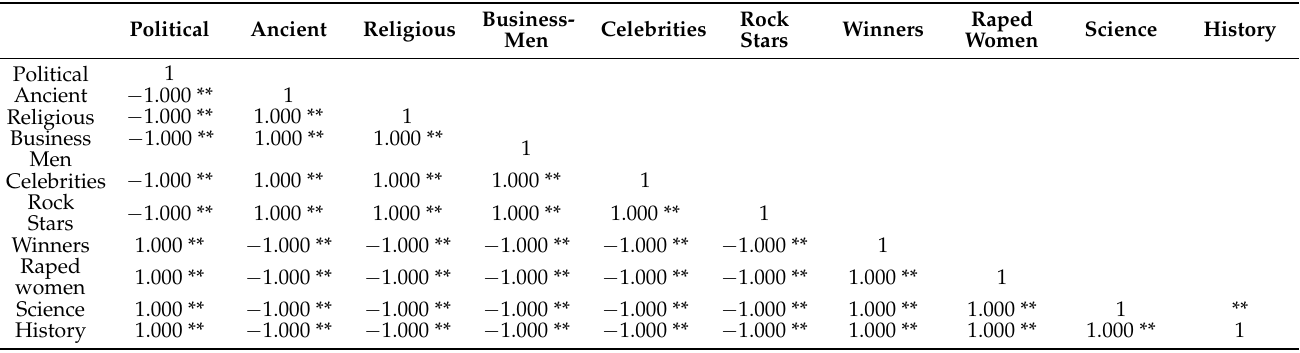
Table 11. The correlation analysis (relevant to p(risk taking) and p(visionary)) for the different